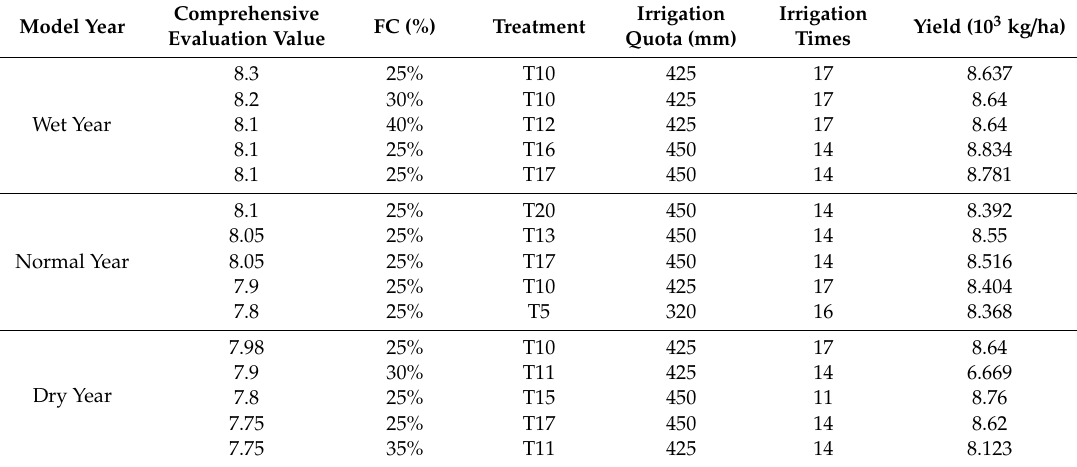
Table 4. Optimal irrigation schedule for the di ff erent